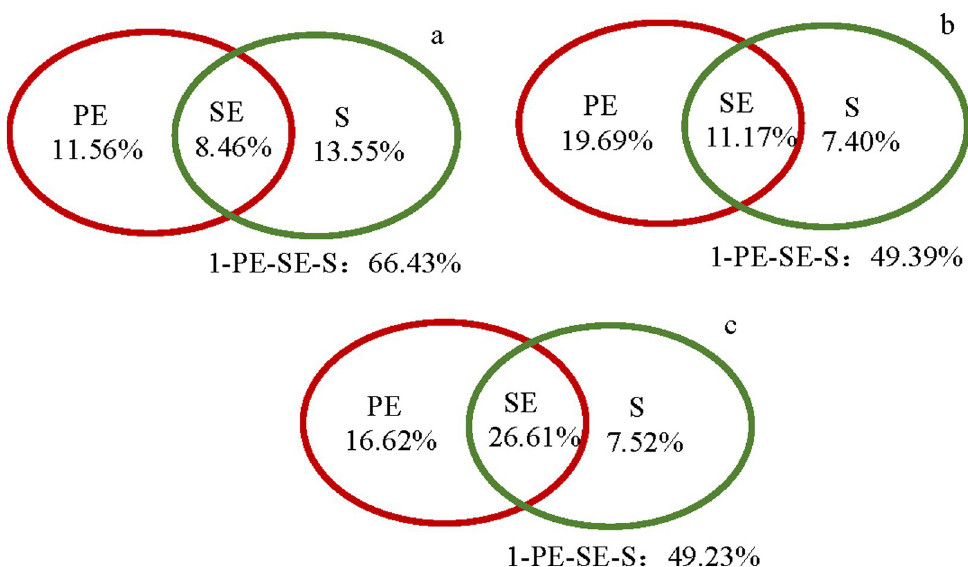
Fig 5. The explanation of environmental filtering and dispersal limitation for the desert plant community assembly. PE = pure environmental interpretation, S = pure spatial interpretation, SE = spatial environmental interpretation, and 1-PE-SE-S = unexplained variation.